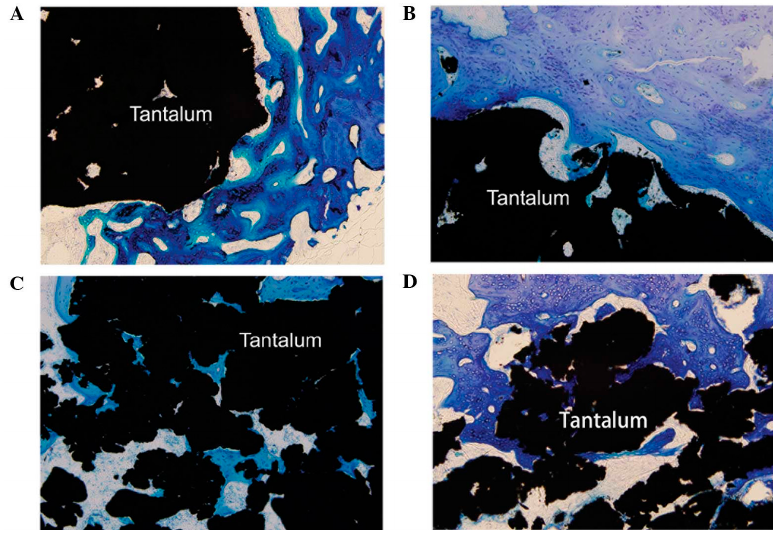
Figure 4. Histological observation of hard tissue in contact with porous tantalum implants at week ( A ) 2; ( B ) 4; ( C ) 8 and ( D ) 12 after implantation (methylene blue staining). Reproduced with permission from [95].